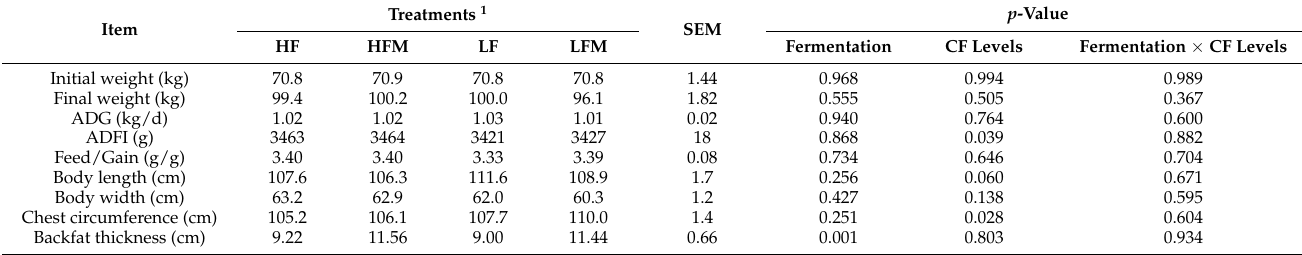
Table 2. Effects of multi-bacteria fermentation and dietary CF level on growth performance in finishing pigs. p -Value Treatments 1 Item SEM HF Fermentation Fermentation × CF Levels Initial weight (kg)